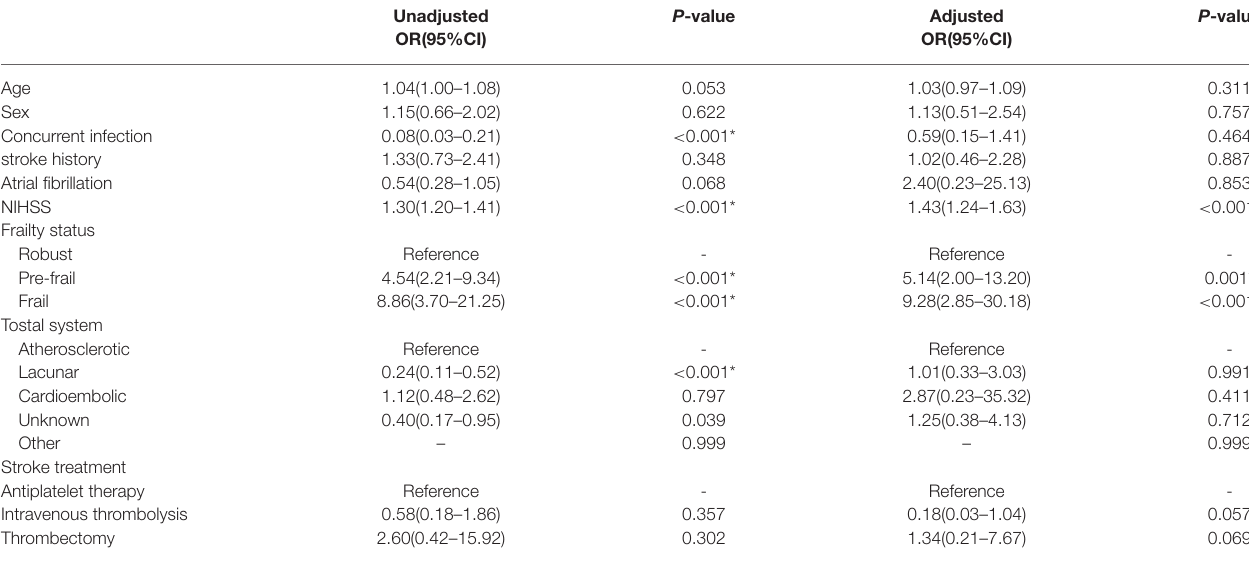
TABLE 7 | Logistic regression for 1-year follow-up on functional outcomes for functional recovery analysis.